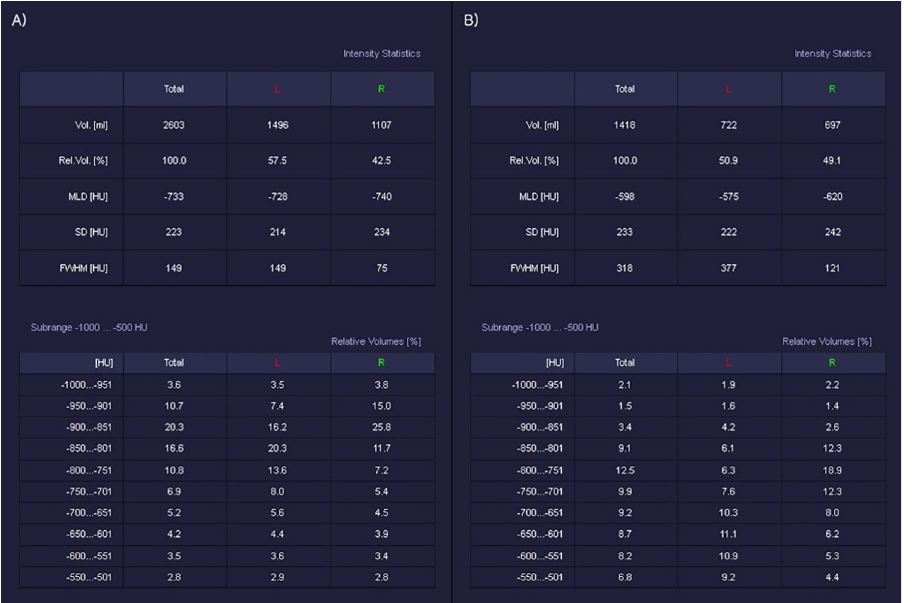
Fig 1. Example of densitometry parameter measurements using the 3D chest CT of a representative subject in the A) inspiratory and B) expiratory phases.